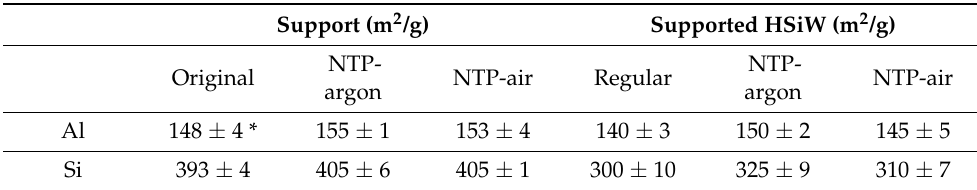
Table 1. Brunauer–Emmett–Teller (BET) surface area of the supports and the catalysts with and without nonthermal plasma (NTP) treatment.